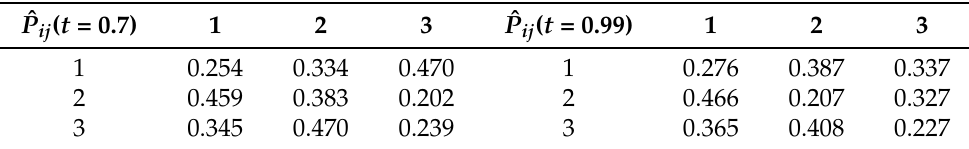
Table 10. Estimators for the transition probabilities of the semi-Markov process for t = 0.7 and t =